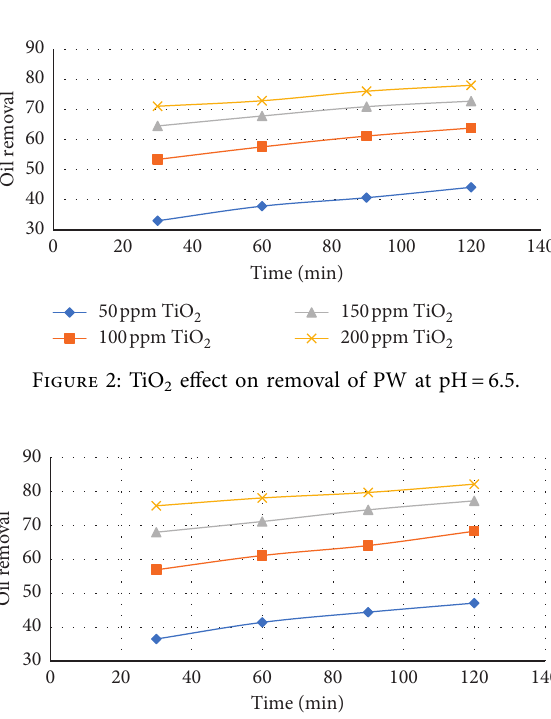
Figure 3: ZnO effect on removal of PW at pH �